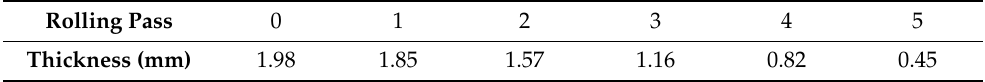
Table 4. Actual rolled thickness of each